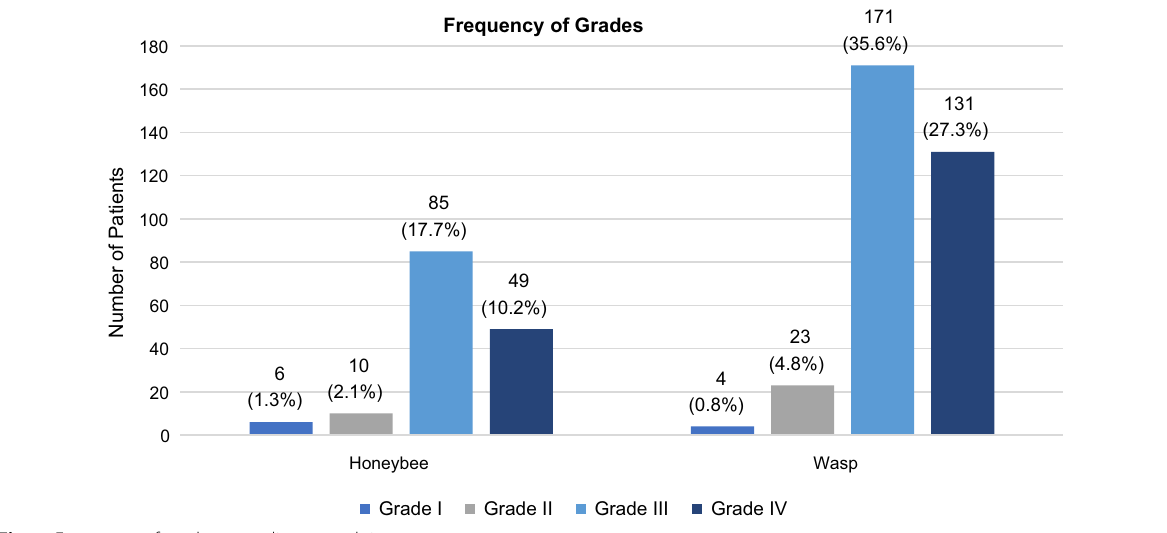
Fig. 1 Frequency of grades according to each